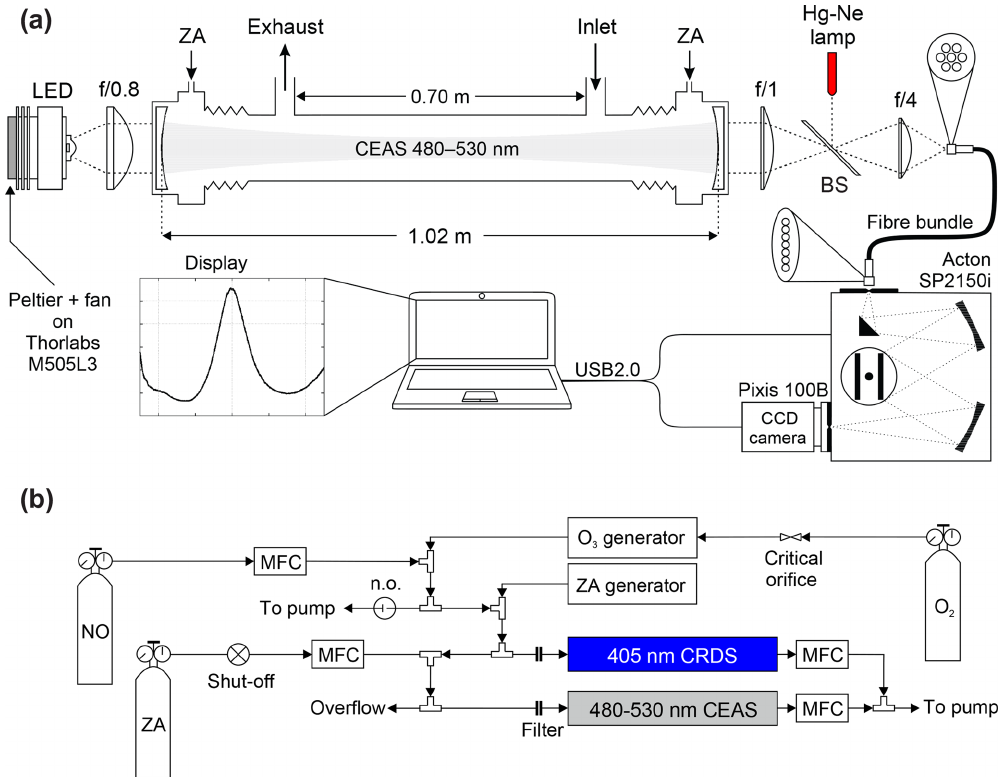
Figure 2. (a) Set-up of the cyan IBBCEAS (not to scale). (b) Set-up of NO 2 calibration gas delivery for instrument characterization experi- ments. Abbreviations: LED – light emitting diode, BS – quartz beam splitter, CCD – charge-coupled device, ZA – zero air, USB – universal serial bus, and MFC – mass flow